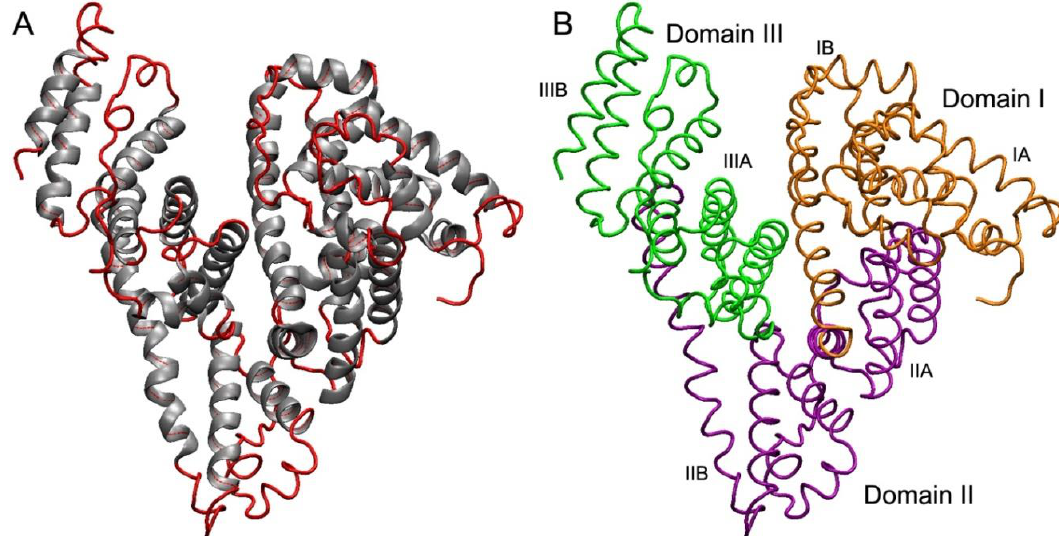
Figure 2. The structure of serum albumin. ( A )—the secondary structure of albumin: the albumin molecule does not contain β -sheets, α -helices are presented in grey, other regions are shown in red. ( B )—the tertiary structure of albumin: domains I, II and III are shown in orange, purple and green, respectively; each domain consists of two subdomains (A and B). To create the figure, a three-dimensional structure of human serum albumin from the PDB database, code 3JQZ [57], was used.